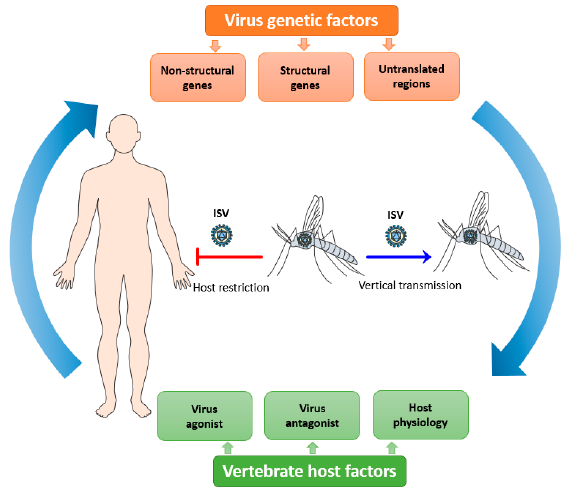
Figure 1. Putative overview of the host tropism of insect-specific viruses (ISVs). ISVs are maintained in mosquito populations by a vertical route of transmission. The infection and replication of ISVs are restricted in vertebrate hosts due to the complex interplay between multiple viral, host, and microenvironment factors.